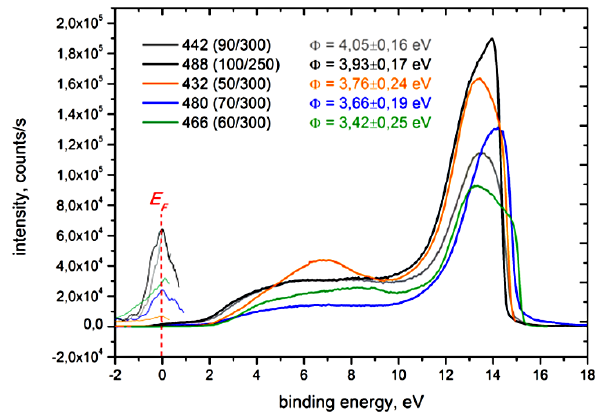
Figure 8. Ultraviolet photoelectron spectra of analyzed LaB 6 films (including sample numbers and deposition parameters; ar- gon flow/DC power) with corresponding measured work functions (Zimmer et al., 2014).